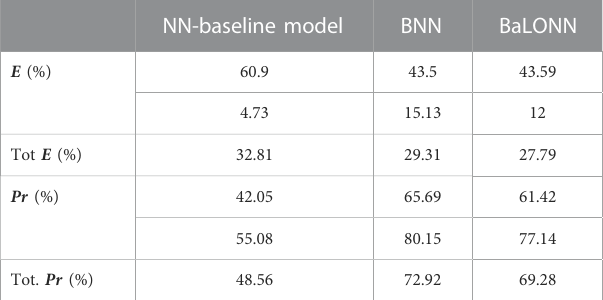
TABLE 5 Validation results for the baseline model, BNNs and BaLONNs.For the stochastic models, we have averaged over 1,000 different